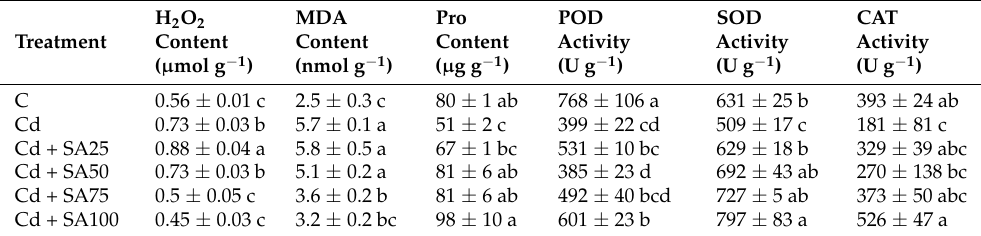
Table 1. H 2 O 2 , MDA, and proline contents, and POD, SOD, and CAT activity levels in the leaves of Tartary buckwheat treated with different concentrations of salicylic